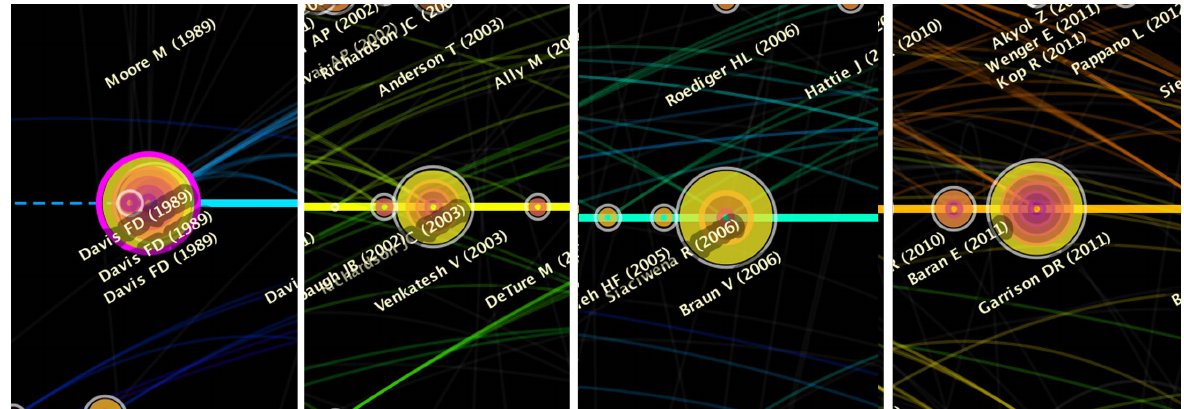
Snapshots of Timeline Visualization From 1990s to